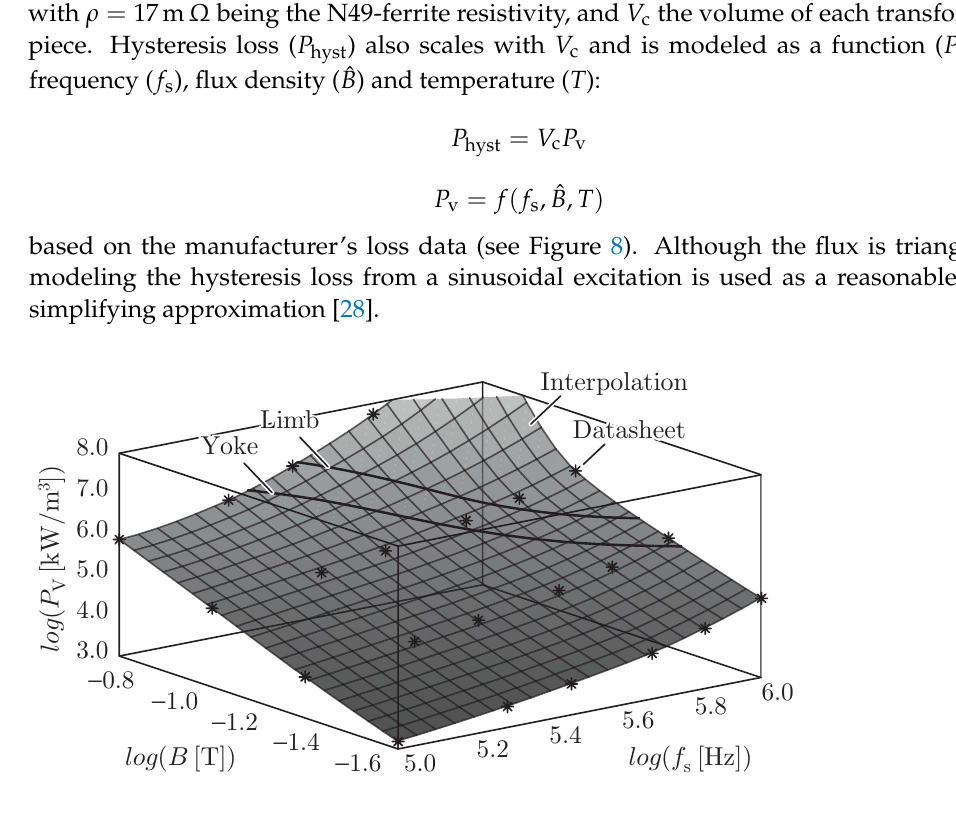
Figure 8. N49-ferrite hysteric losses (volumetric) as a function of flux density and frequency (axes in log scale). Stars are datasheet-given values, which are interpolated as inputs into continuous loss models. The frequency-dependent limb and yoke fluxes are calculated using (8) and shown with black lines on the top of the interpolation surface, indicating that core losses will decrease at higher operating frequencies due to the lower flux